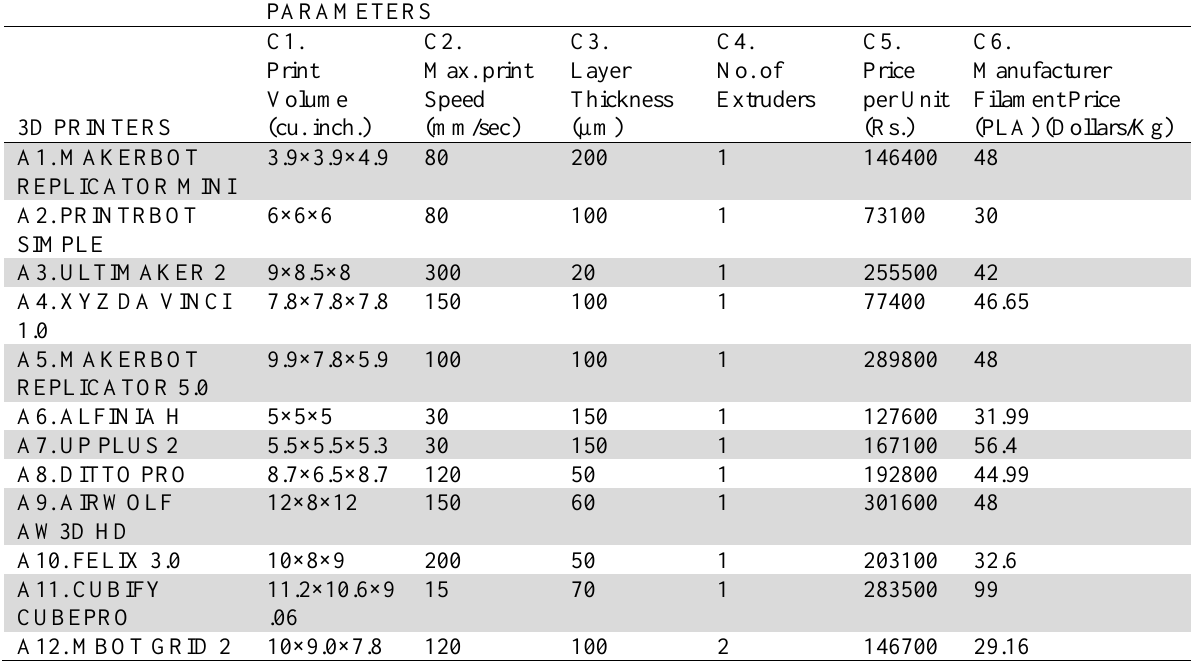
Fig. 2. Different 3D Printer Parameters